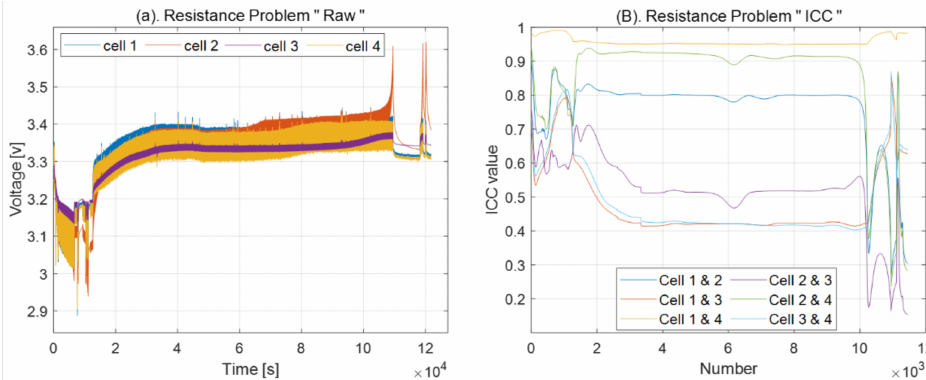
Figure 16. Resistance problem (( a ) voltage and ( b ) ICC value).